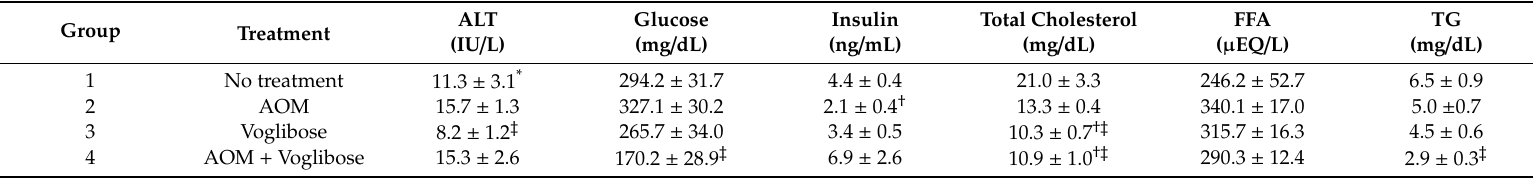
Table 2. Serum parameters of the experimental